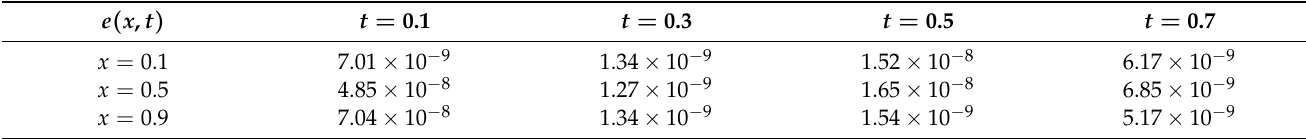
Table 3. Absolute error of each point when α =